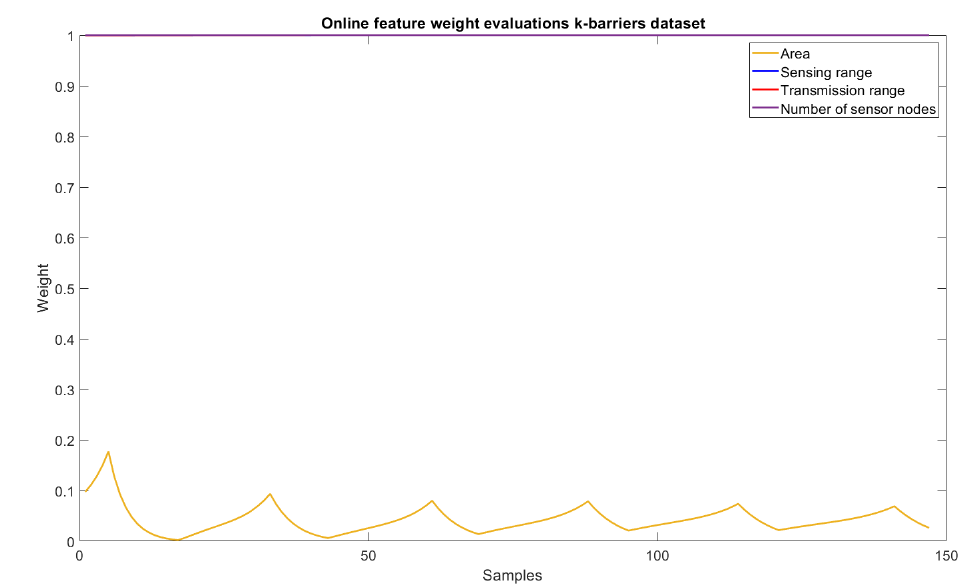
Figure 6. Result in trend lines for the evaluation of the k-barriers prediction.